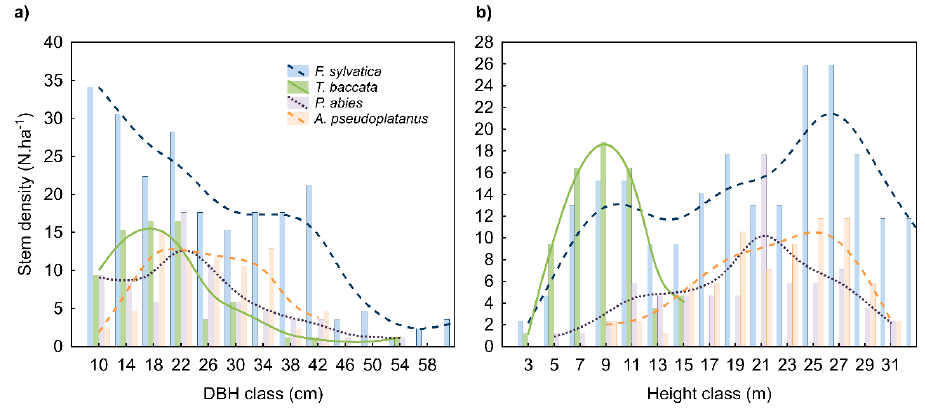
Figure 1. ( a ) Diameter and ( b ) height distributions of four tree species of the studied forest stand. DBH: diameter at breast height.